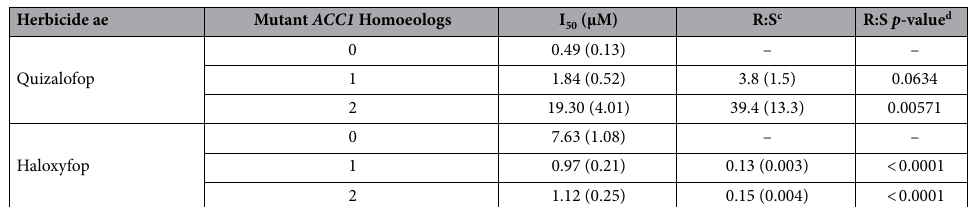
Table 2. Relative herbicide dose effects on ACCase activity by genotype a for 50% inhibition (I 50 ) b . a Genotype refers to the number of homozygous mutations in ACC1 that result in a A2004V amino acid substitution, with up to three possible on group 2 chromosomes in hexaploid wheat (2n = 6x). These mutations result in quizalofop-resistant wheat ACCase. b Activity values (DPM) normalized to percent untreated controls and transformed with Box-Cox transformation per genotype for each herbicide. The dose effect of each herbicide is modeled with a 2-parameter log-logistic function to estimate I 50 values. c Resistance factor, calculated by dividing the I 50 of a quizalofop-resistant genotype by the susceptible genotype I 50 . d Student’s t-test p -value (α = 0.05) of resistance factor ratios.